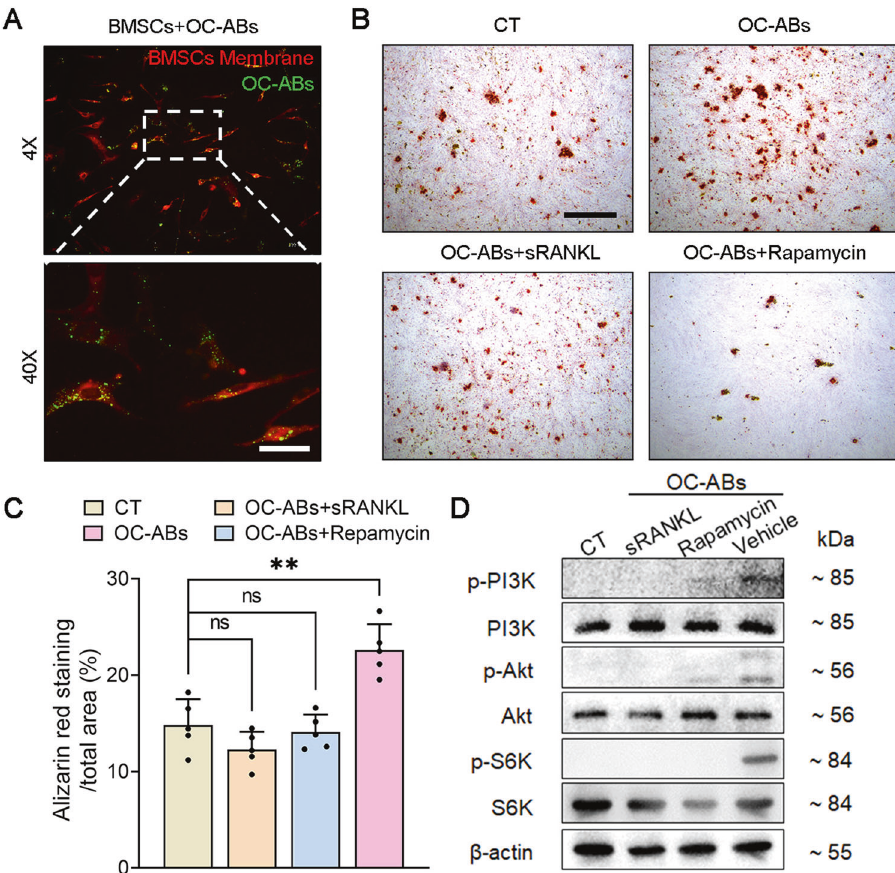
Fig. 4 Membrane RANK of OC-ABs activates the reverse signaling pathway in bone mesenchymal stem cells. A Fluorescence images showed that OC-ABs were enriched on the cell membrane of BMSCs, scare bar = 30 μ m. B Representative Alizarin Red stained images for each indicated group, scare bar = 100 μ m. C Quanti fi cation of mineralized areas from indicated group, n = 5. D Western blot showed the expression levels of mTOR downstream signaling pathway proteins in each indicated group. One-way ANOVA analysis was used to compare multiple sets of data in ( C ), * p < 0.05, ** p < 0.01, ns non-signi fi